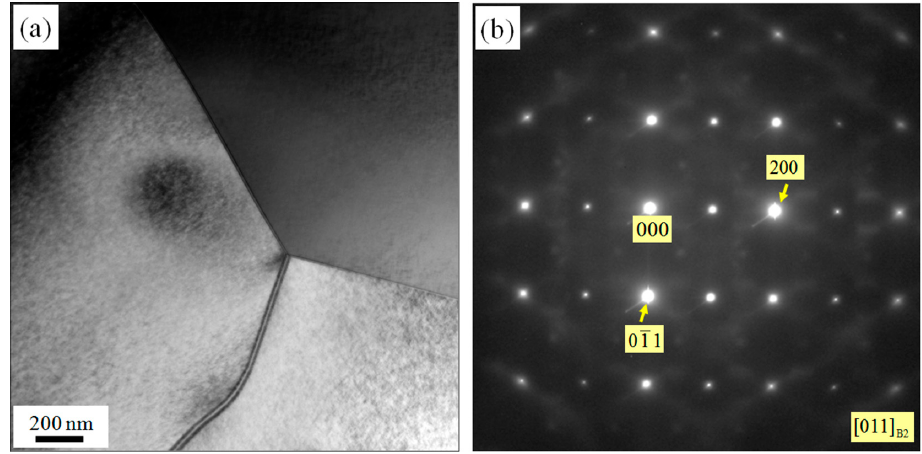
Figure 3. Transmission electron microscope (TEM) micrographs of Ni-49.1 at % Ti SMA: ( a ) bright field image; ( b ) diffraction pattern of ( a ).